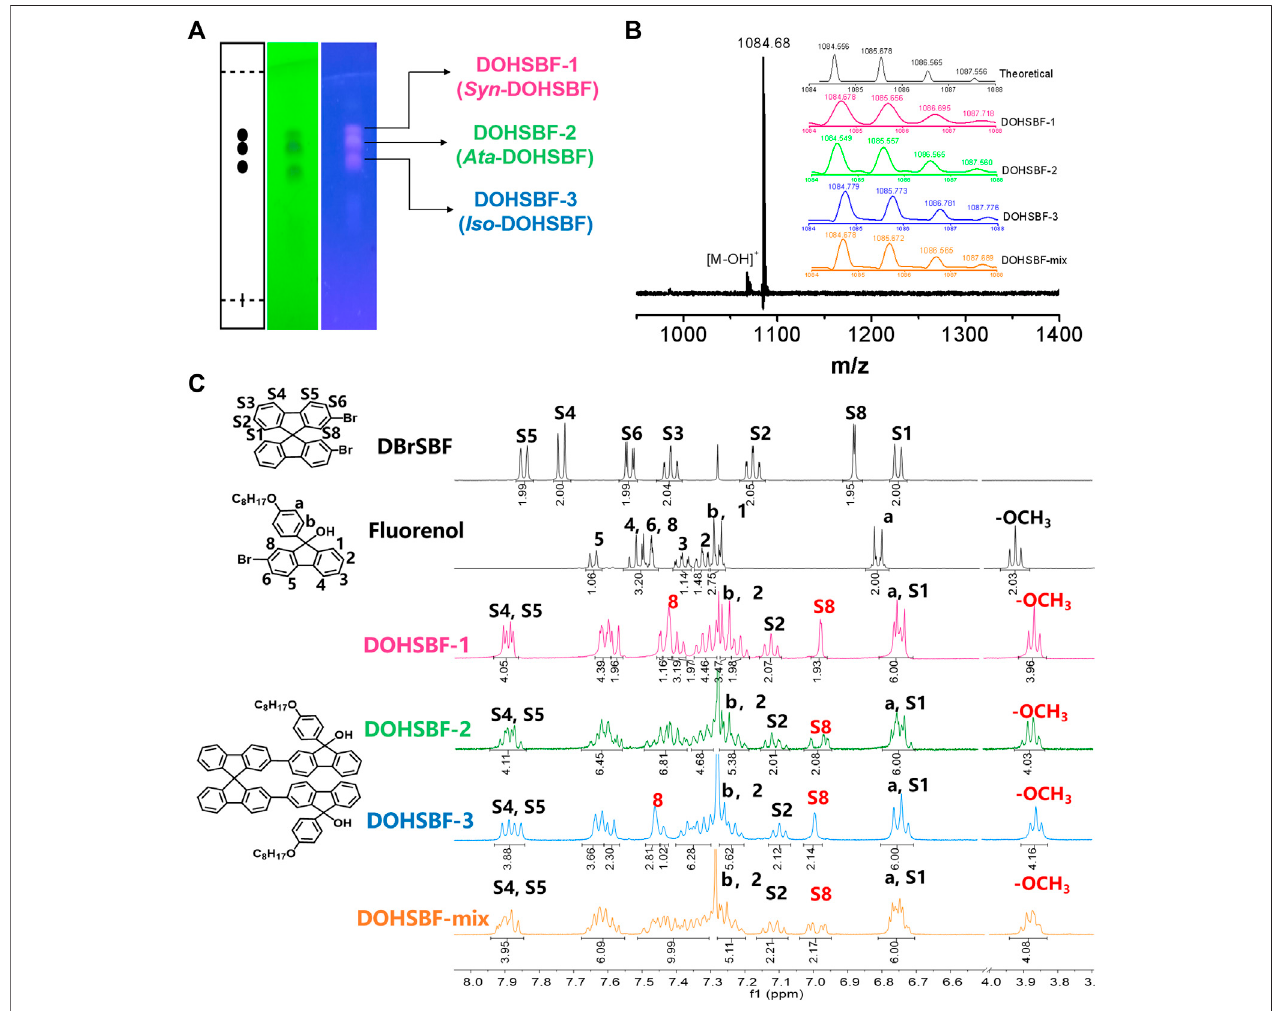
FIGURE2|(A) TLCplateimagesoftheDOHSBFreactionmixtureunderthe254 nmlamp(left)andthe365 nmlamp(right)(themobilephaseisPE:DCM(1:3)and the TLC plate has been placed into jar twice). (B) MALDI-ToF-MS spectra of DOHSBF. (C) 1 H NMR of DBrSBF, fl uorenol, and DOHSBF in the aromatic region.